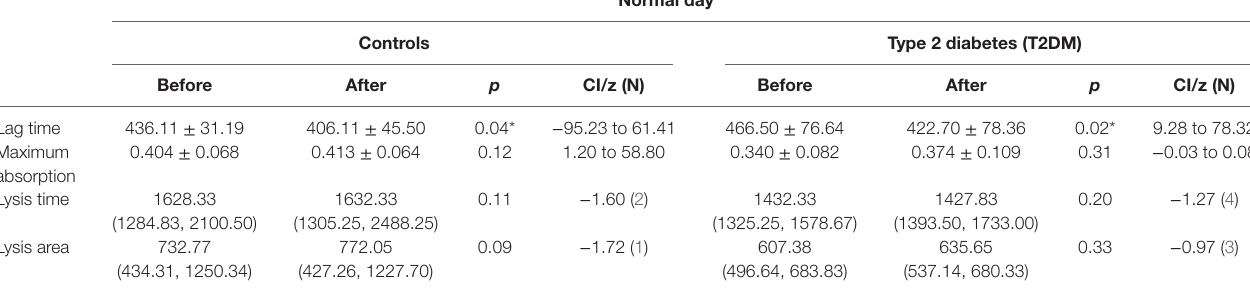
Table 5 | Results from the control day.